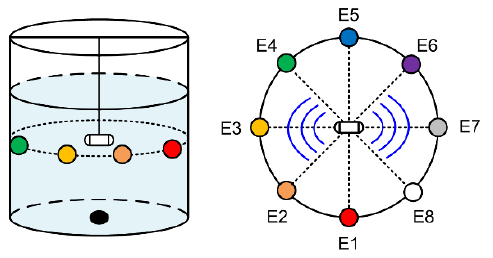
Figure 7. The received condition according to the position of the capsule and the